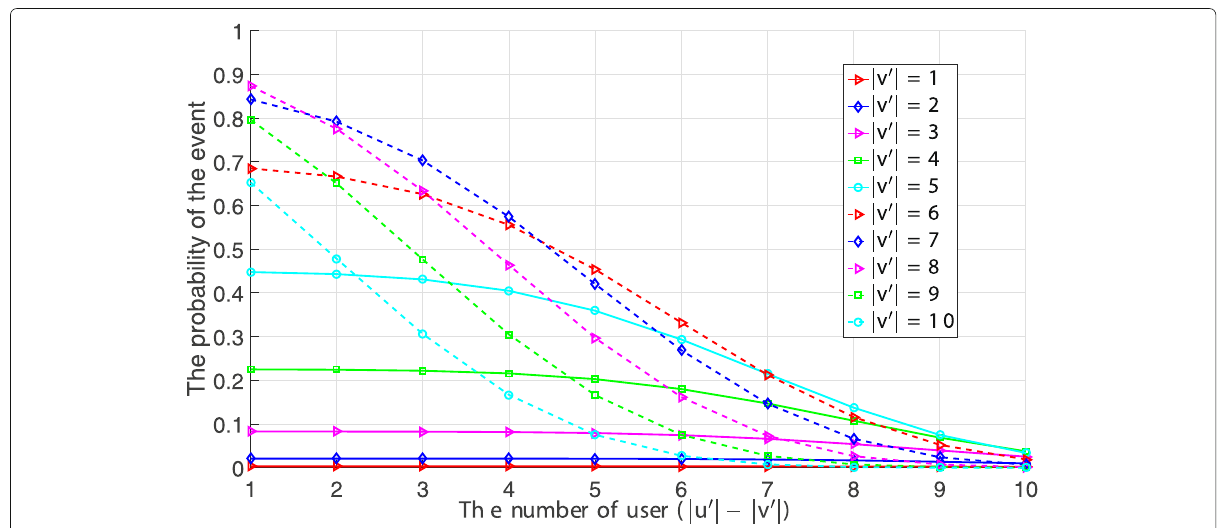
Fig. 9 Probability of the expected scenario with different number of users